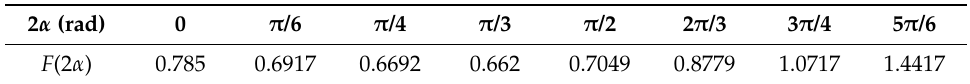
Table 1. Values of F (2 α ). Reproduced with permission from Berto, F.; Lazzarin, P. Mater. Sci. Eng.: R Published by Elsevier, 2014 [16].